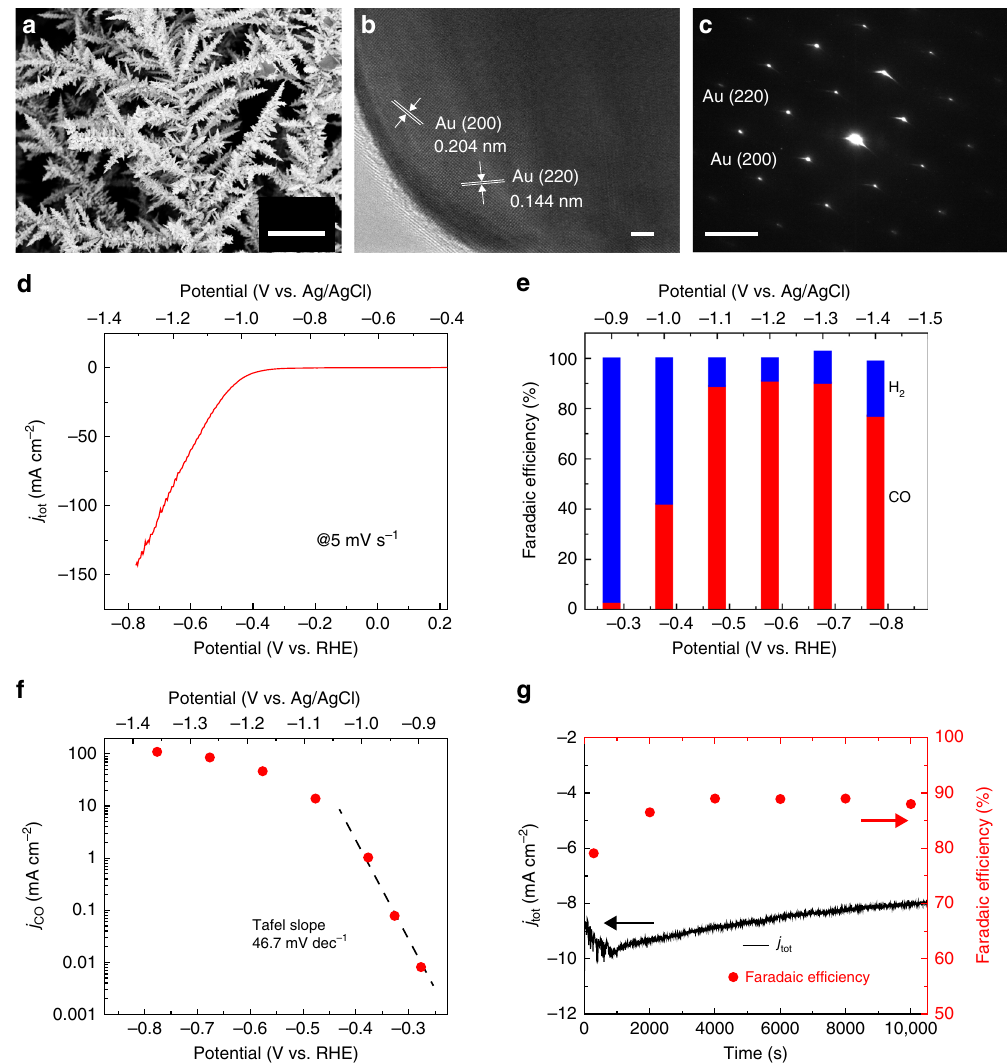
Fig. 2 CO 2 electroreduction on nano-Au catalysts. a SEM image of nano-Au catalysts on carbon papers. b HRTEM image and c SAED pattern of a representative nano-Au at the zone axis of <002 > direction. d Linear sweep voltammetry curve of nano-Au electrocatalysts in CO 2 -saturated 0.5 M KHCO 3 solution at a sweep rate of 5 mV s − 1 . e Faradaic ef fi ciency for CO (red bars) and H 2 (blue bars) production on nano-Au at various potentials ranging from – 0.27 to – 0.77 V vs. RHE. f The current-voltage ( j – V ) curve of CO production partial current density versus potential on nano-Au and kinetics analysis of the CO 2 electroreduction on nano-Au. g Stability of CO 2 electroreduction activity of nano-Au at – 0.47 V vs. RHE, including the total current density (left y -axis) and FE CO (right y -axis). The scale bars are 10 μ m in a , 2 nm in b and 5 1/nm in